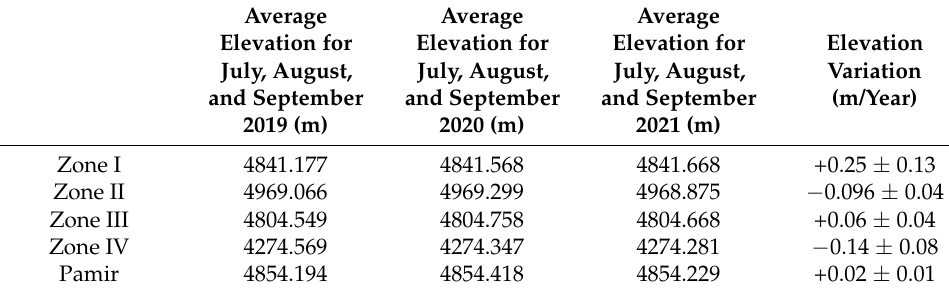
Figure 8. Spatial yearly average variation in the GSE. Table 2. Interannual variation of GSE for the